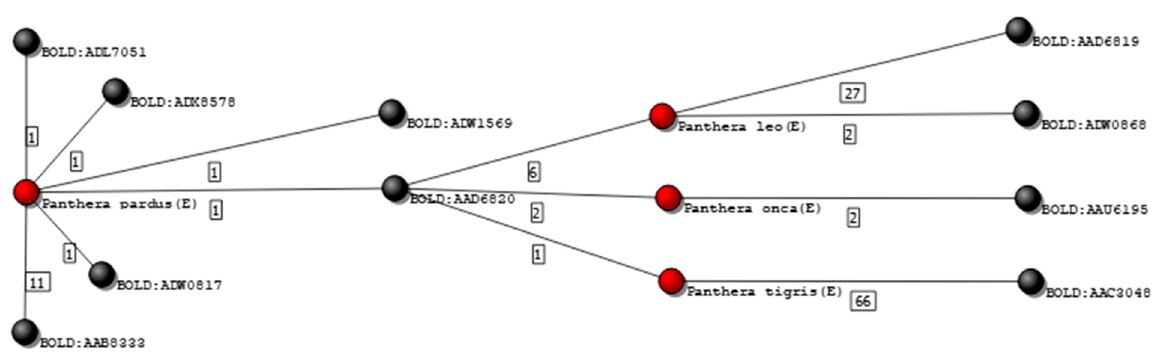
Figure 8. Isolated graph of species P. pardus , P. leo , P. onca, and P. tigris . Nodes colored in black represent genetic clusters, and nodes colored red represent species graded as E.